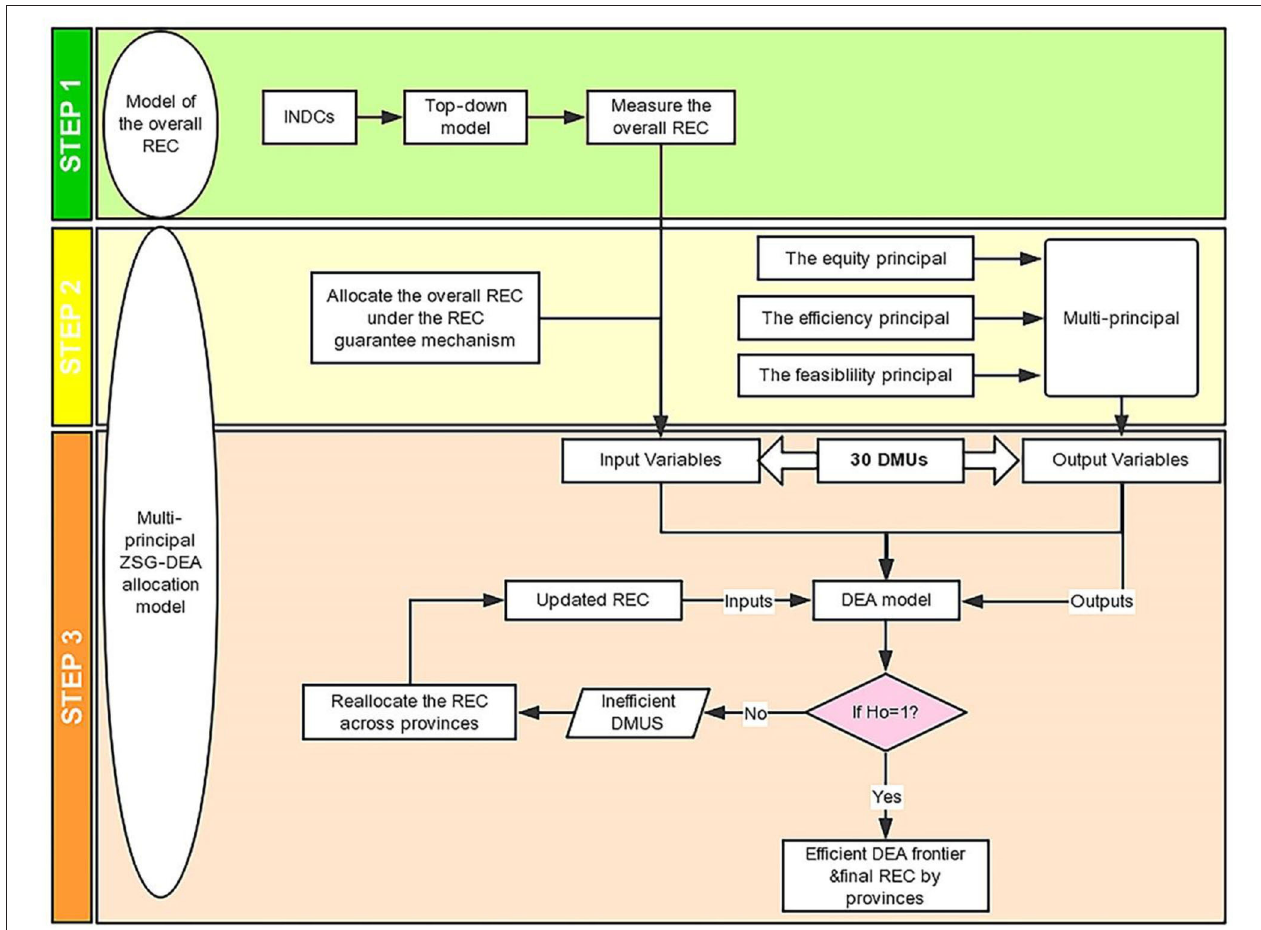
FIGURE 3 | The model design